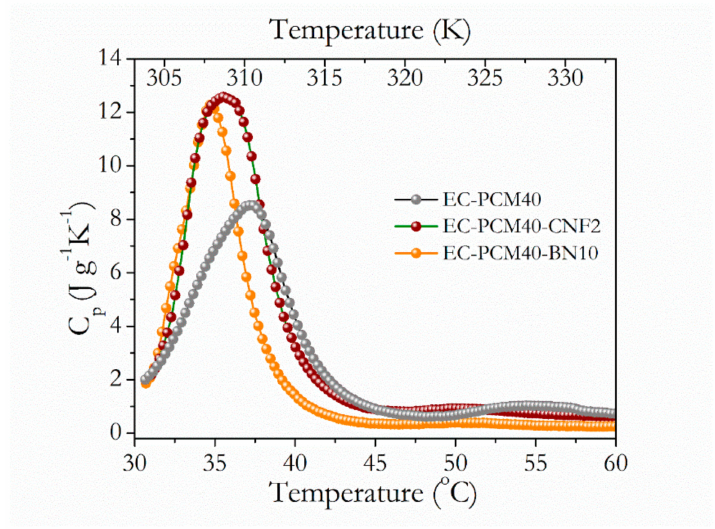
Figure 3. C p versus Temperature ( ◦ C) curves of the EC-PCM40, EC-PCM40-CNF2, and EC-PCM40-BN10